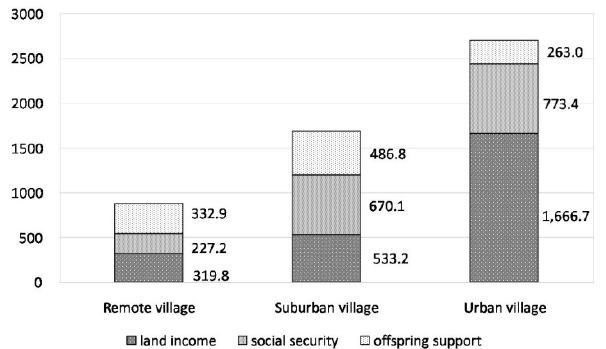
Figure 3. Income sources of the elderly in rural villages (yuan/month).